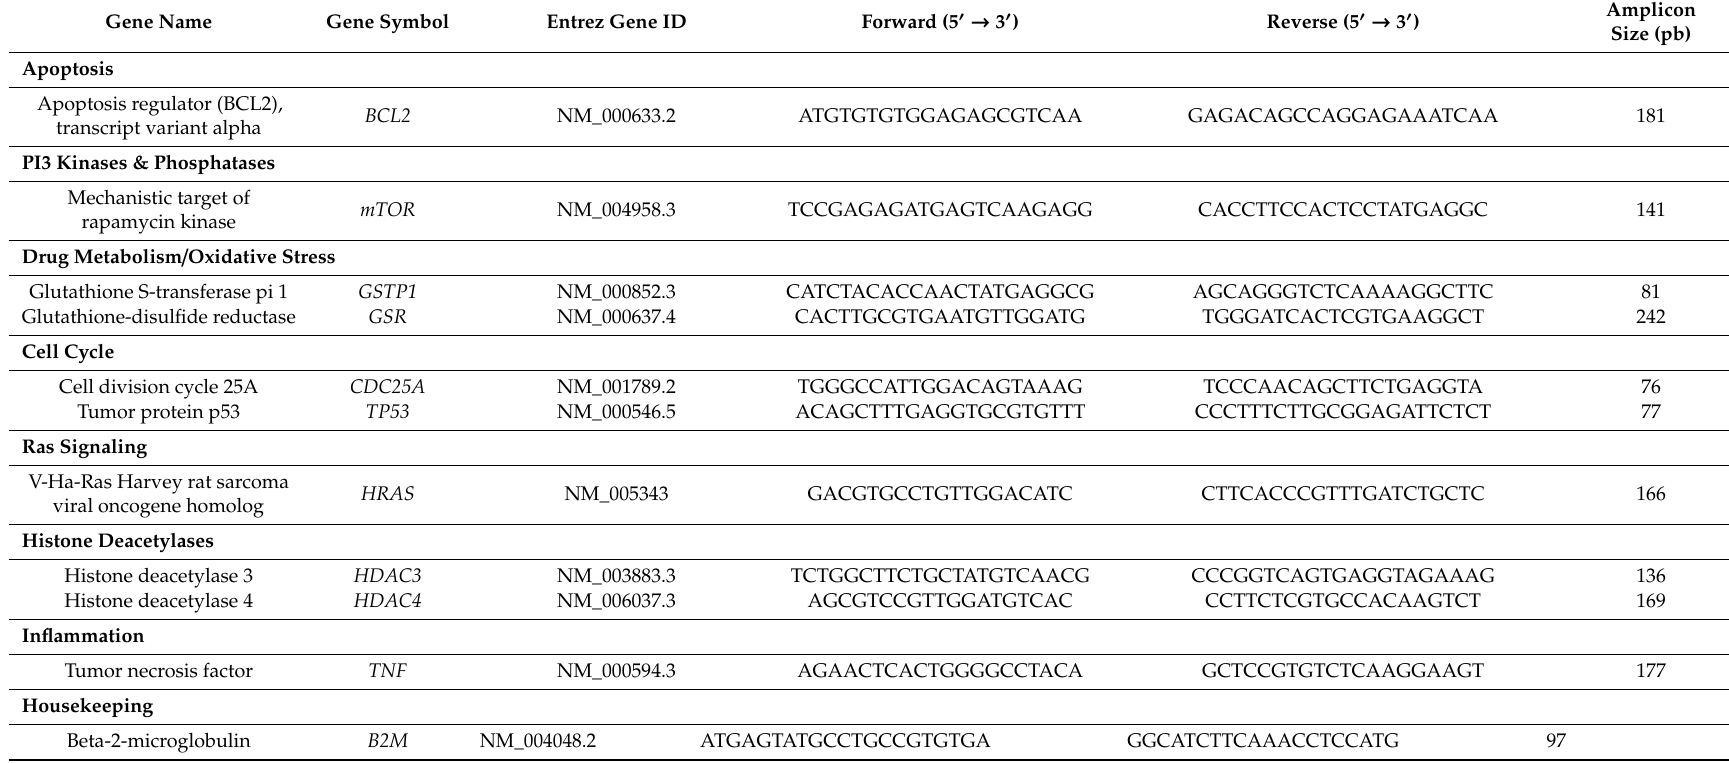
Table 4. Quantitative real-time (qPCR) Primer